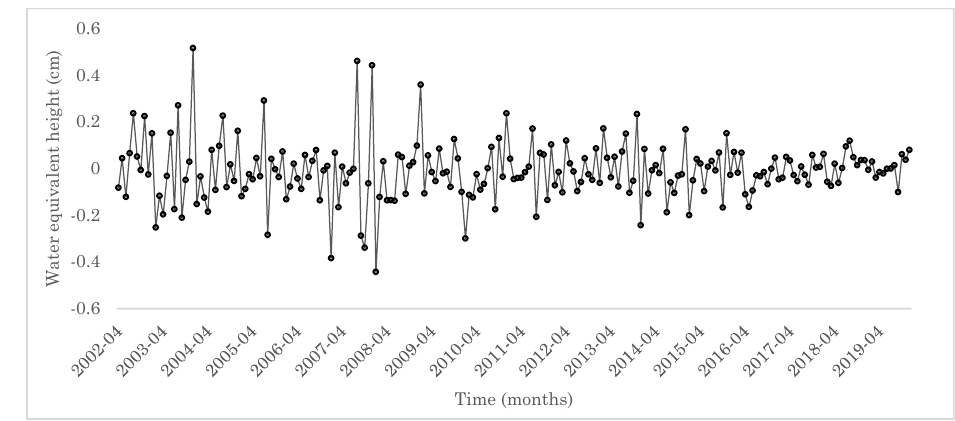
Figure 4. GWSC from monitoring wells in the Arlit mining area.